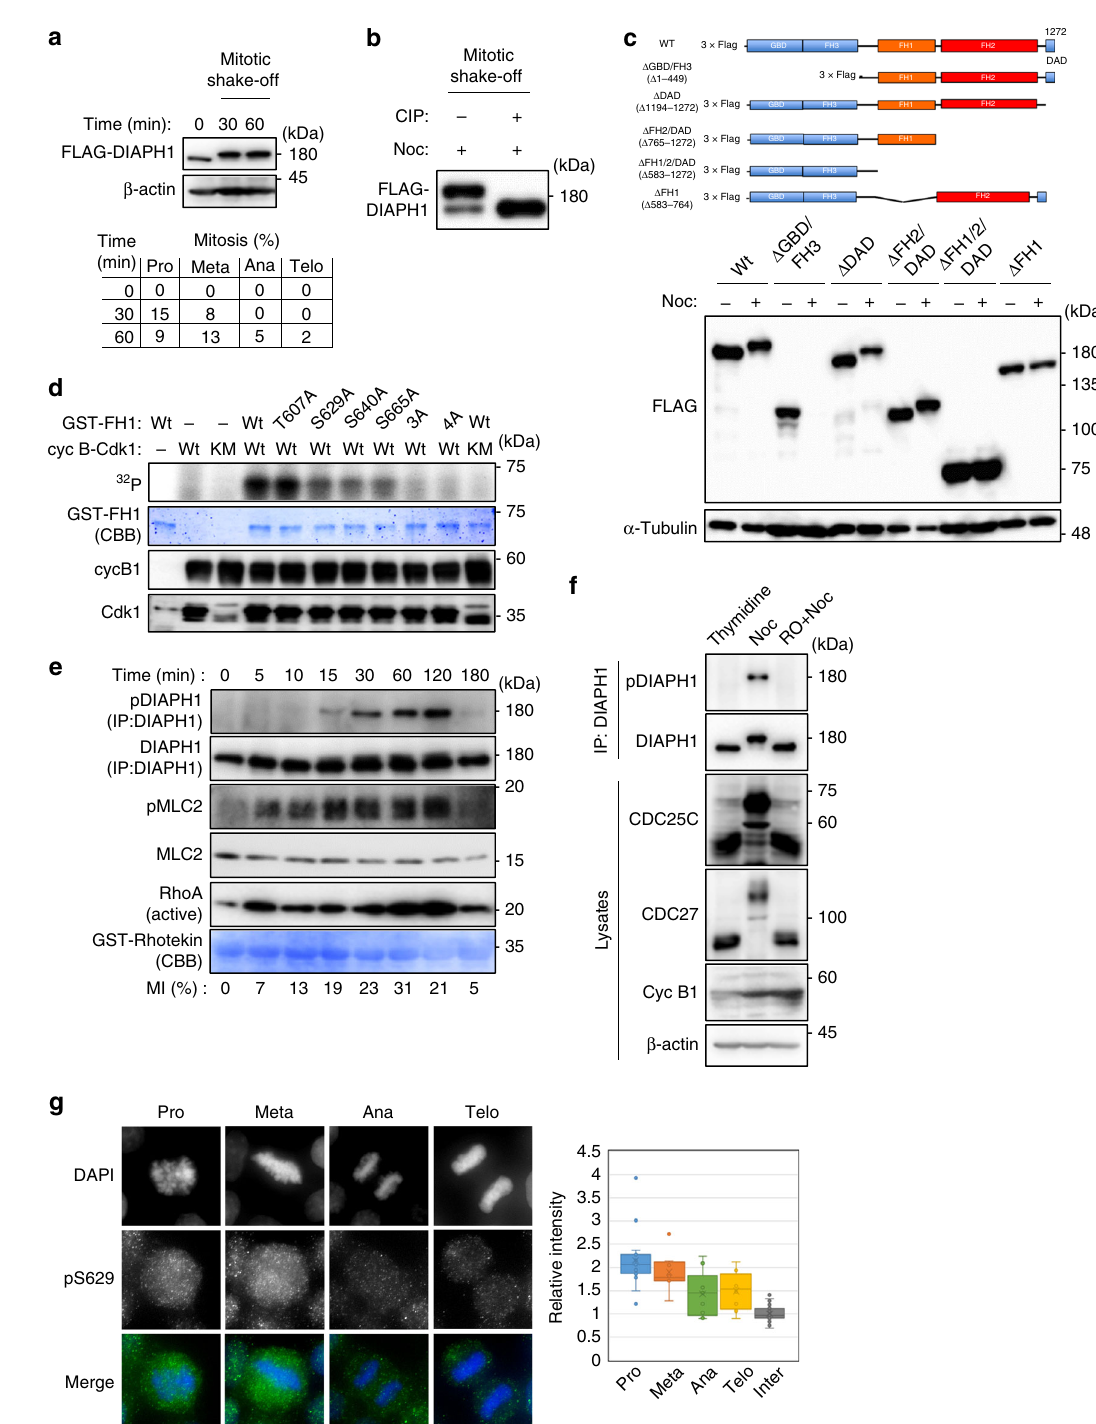
pan-cell staining excluding chromosomes (Fig. 1g). The phos- phorylation signal was detected in HeLa cells synchronized with nocodazole, but was not detected in those synchronized with RO- 3306 plus nocodazole (Supplementary Figure 3d). In addition, the phosphorylation signal was detected in inducible DIAPH1- knockdown HeLa (DIAPH1-KD) cells expressing Wt DIAPH1, but was not in those expressing 3A mutant (T607A/S640A/ S665A) (Supplementary Figure 3e). These results further con fi rmed the speci fi city of the anti-pS629 antibody. NATURE COMMUNICATIONS| (2019) 10:981